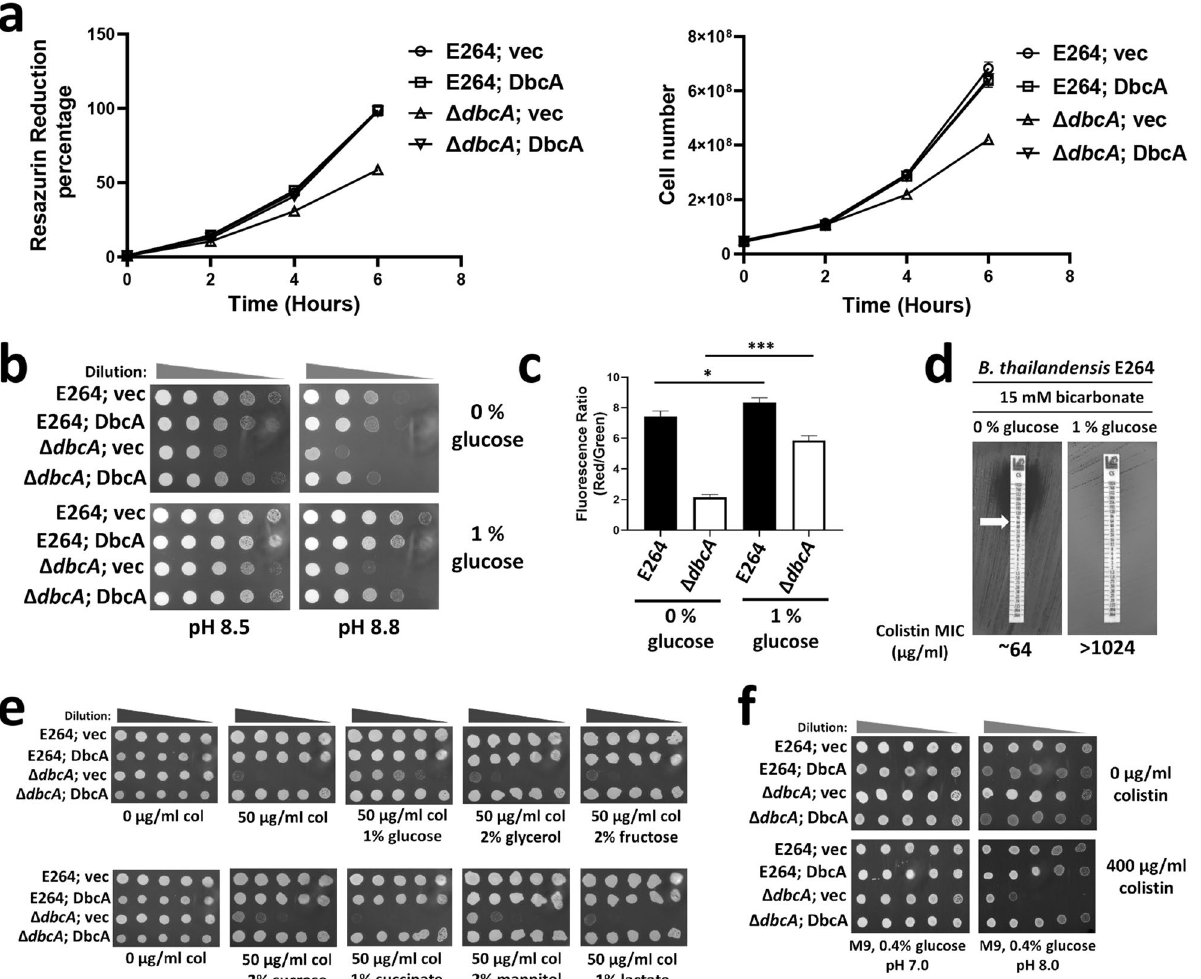
Figure 6. Glucose dependent colistin resistance. ( a ) Lower metabolic activity of B. thailandensis ∆ dbcA . Relative metabolic activity was measured by the percentage of the reduced form of Resazurin within 6 h of growth. 5 × 10 7 cells of overnight cultures of indicated strains were inoculated in 25 ml fresh MH1 broth, with 100 µg/ml Tmp, 0.015% Resazurin dye and grown for 6 h. Resazurin reduction percentage for each strain was calculated (left) and the cell number was also determined (right) for each time point. ( b ) Compensation of alkaline pH stress by glucose supplementation in the growth media. Spot assay of 1:10 dilutions of all four B. thailandensis strains on MH1 media with 100 µg/ml Tmp, 0.002% rha, and 0 and 1% glucose. The pH was adjusted with either HCl or NaOH. ( c ) Partial compensation of membrane depolarization of B. thailandensis ∆dbcA by glucose. Membrane potential was measured for B. thailandensis strains (E264 and ∆dbcA ) grown in MH2 media with different amounts of glucose as indicated. *; p < 0.05, and ***; p < 0.001. ( d ) Reversal of bicarbonate induced sensitization of B. thailandensis E264 to colistin by glucose supplementation. MIC was determined on MH2 agar plates with 15 mM sodium bicarbonate and different concentrations of glucose as indicated. ( e ) Effect of different carbon sources in colistin resistance. Spot assay of 1:10 dilutions of indicated B. thailandensis strains in MH2 agar plates with 100 µg/ml Tmp, 0.002% rha, and different carbon sources. Plates were analyzed after 48 h of growth at 37 °C. ( f ) Colistin sensitivity of B. thailandensis ∆dbcA in M9 media. 1:10 dilutions of indicated strains were spotted on M9 agar plates with 0.4% glucose with or without 400 µg/ml colistin adjusted to different pH using either HCl or